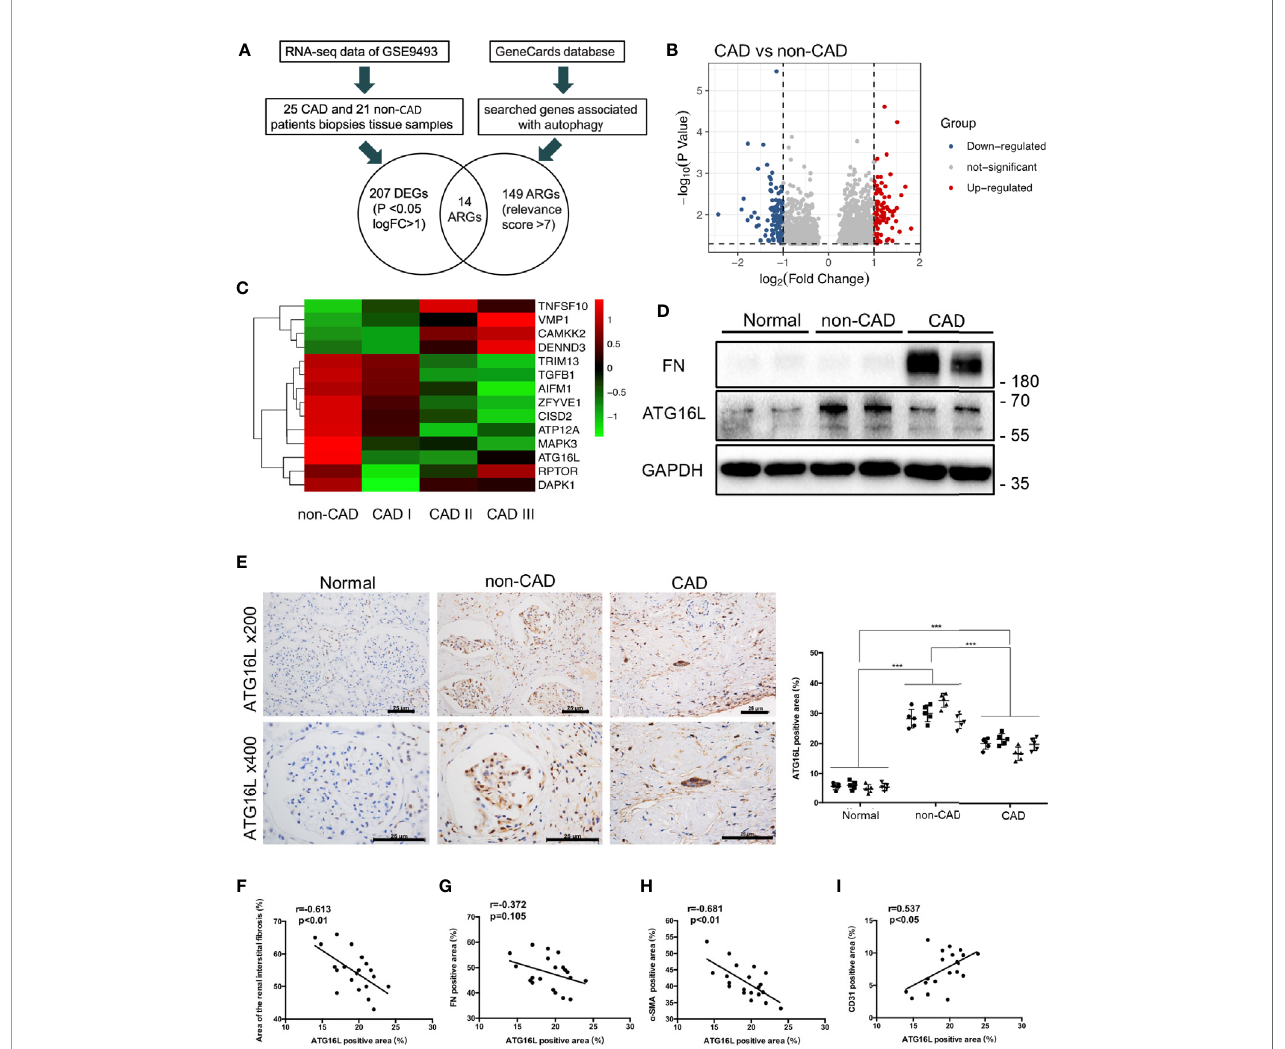
FIGURE 2 | ATG16L expressions in CAD and the non-CAD patients. (A) The diagram of the dataset recruitment work fl ow (B) Volcano plot of differential gene expression analysis between non-CAD (n=21) and CAD (n=25) kidney tissues from GEO pro fi les (GSE9493) (C) Heatmap indicating the differential expressions of the 20 selected ARGs. Expression values were presented in red and green to indicate expression upregulation and downregulation, respectively. (D) Representative western blot assay results of the protein expressions of ATG16L and FN in normal, non-CAD and CAD patient kidney tissues from our center. (E) Representative IHC images of ATG16L expressions in normal, non-CAD and CAD tissue (n=4) (×100, ×200, scale bar: 25 m m). Each patient selected 5 different sites of transplanted kidney. Semi-quantitative analyses of IHC staining were reported (*** P < 0.001, vs. the non-CAD group, Student t test). (F) The correlation analysis between ATG16L and area of renal interstitial fi brosis (r=0.613, P < 0.01), (G) The correlation analysis between ATG16L and FN (r=0.372, P =0.105), (H) The correlation analysis between ATG16L and a -SMA (r=0.681, P < 0.01), (I) The correlation analysis between ATG16L and CD31(r=0.537, P < 0.05) were determined using Pearson correlation analysis. (n=4, biological independent samples. Each patient selected 5 different sites of transplanted